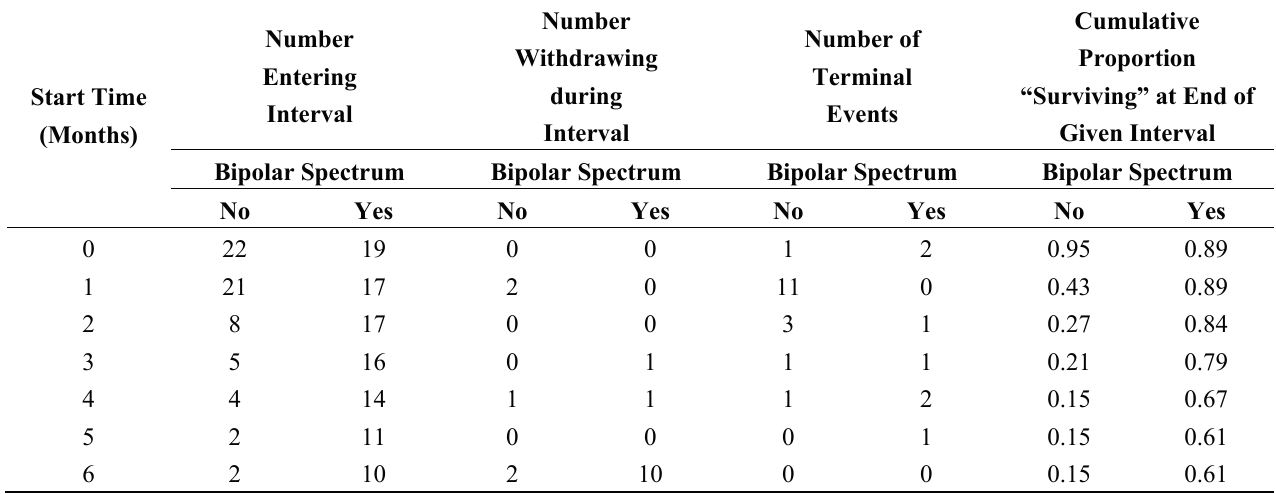
Table 1. “Survival” in treatment of depressed alcoholics with and without bipolar spectrum, treated with acamprosate after